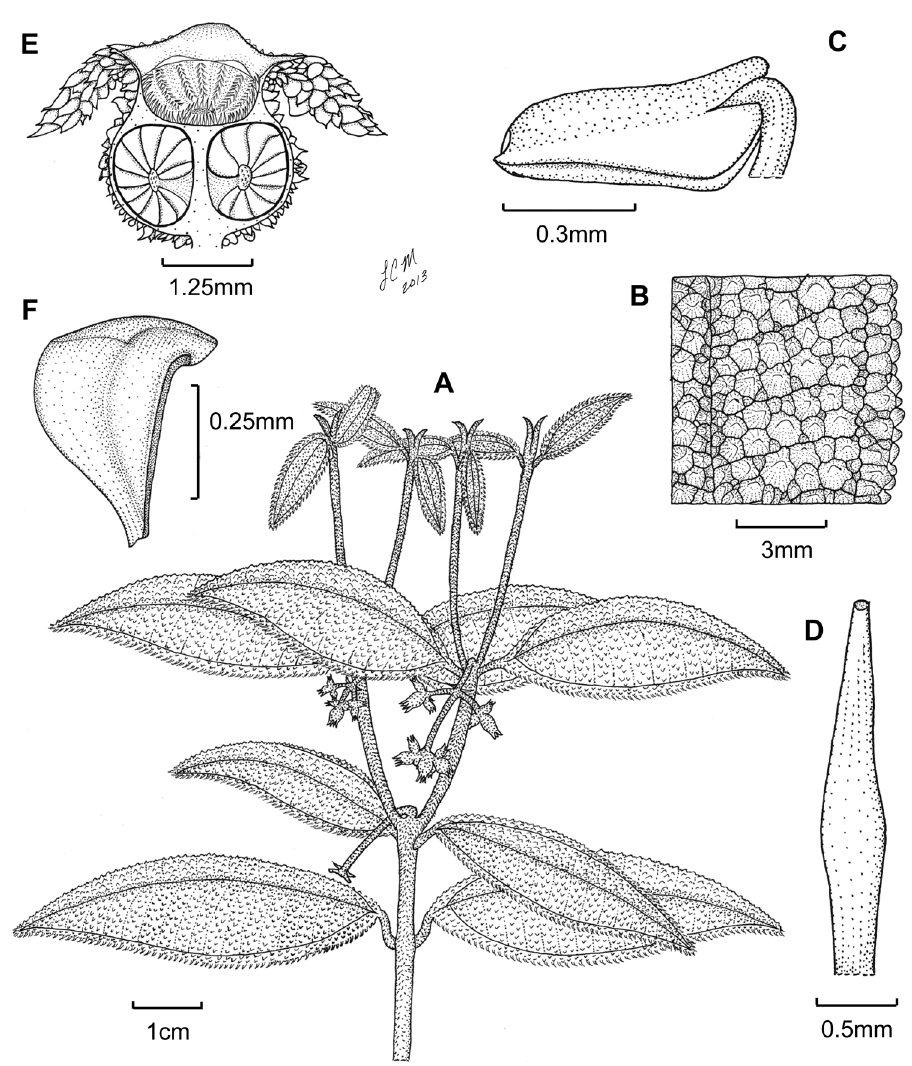
Figure 16. Illustration of Miconia bullotricha . A habit B close-up of leaf adaxial surface C immature stamen D style E fruit longitudinal section F seed (all from Bisse et al. HFC-49930 ). Reproduced with permission from Majure et al.